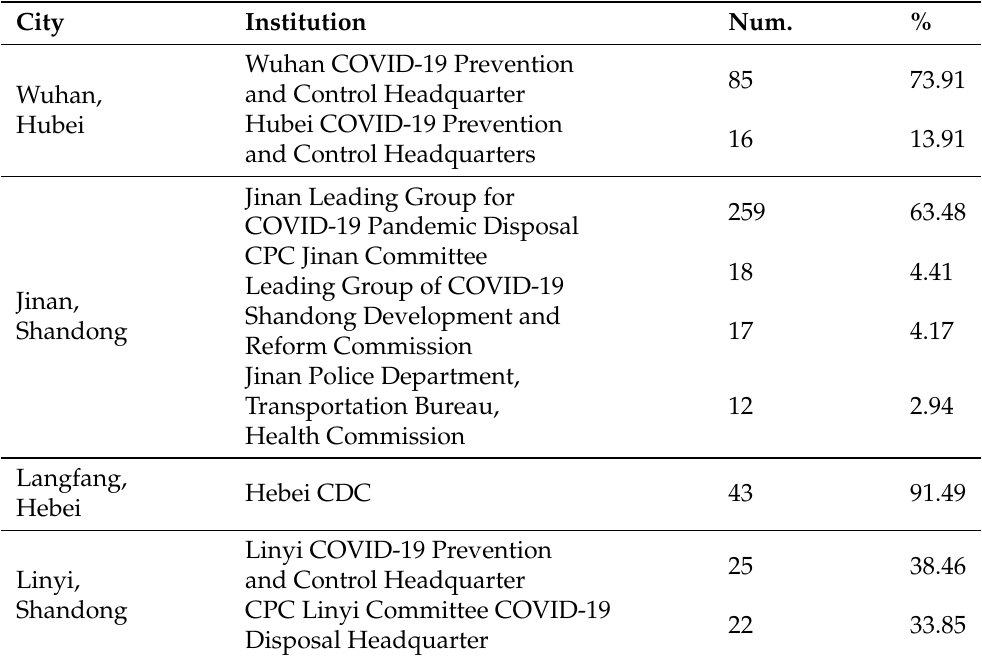
Table 11. Major source of public-interest